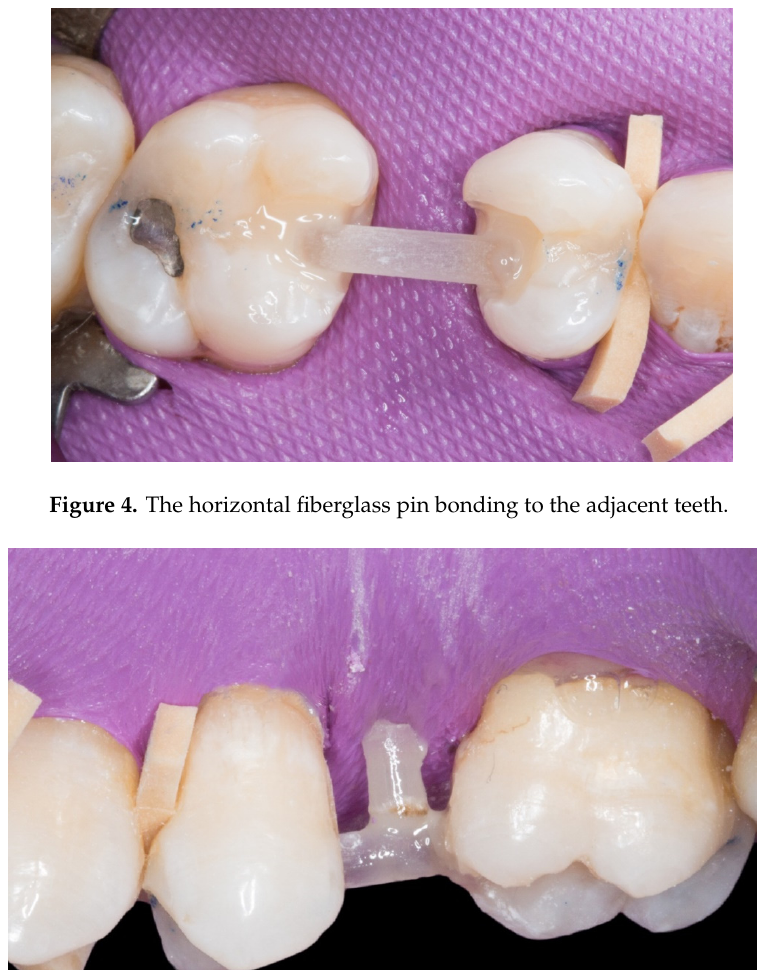
Figure 3. The transverse structure of the future fiber-reinforced composite bridge (FRCB).